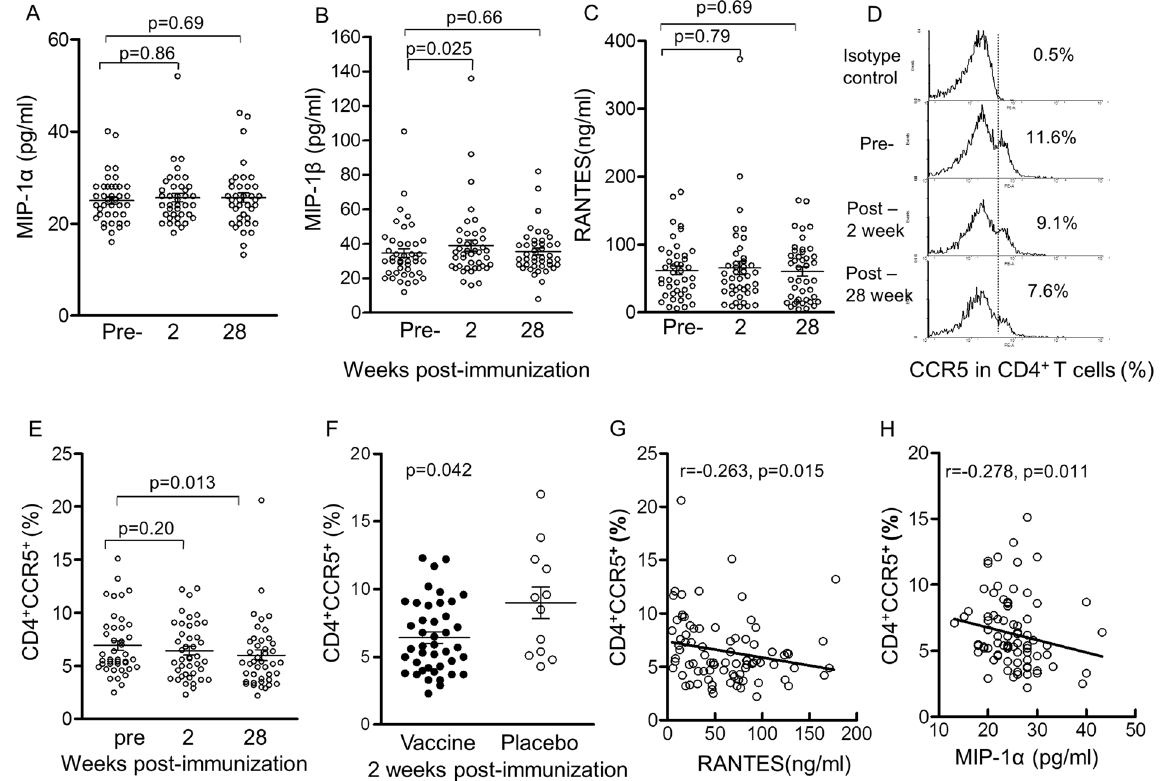
Figure 5. The effect of vaccination on production of CC chemokines and CCR5 in CD4 + T cells, 2 and 28 weeks after the last immunization. ( A ) MIP-1 α in pg/ml, ( B ) MIP-1 β in pg/ml, ( C ) RANTES in ng/ml, all from different subjects ( D ) Representative flow cytometry of ( E ) proportion of CCR5 in CD4 + T cells before and after immunization(%), ( F ) proportion of CCR5 in vaccinated, compared with the placebo group. ( G ) Inverse correlation between CD4 CCR5 + T cells and RANTES or ( H ) MIP-1 α ; Immunized (n = 42) and placebo (n =